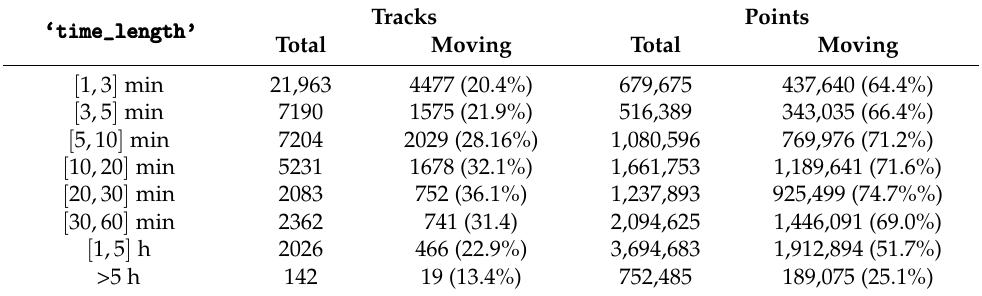
Table 14. Total number of collected data and distribution per time length and part of the measurement tracks and points that have been collected in motion (only data with geolocalization are considered, with a speed greater than 0.5